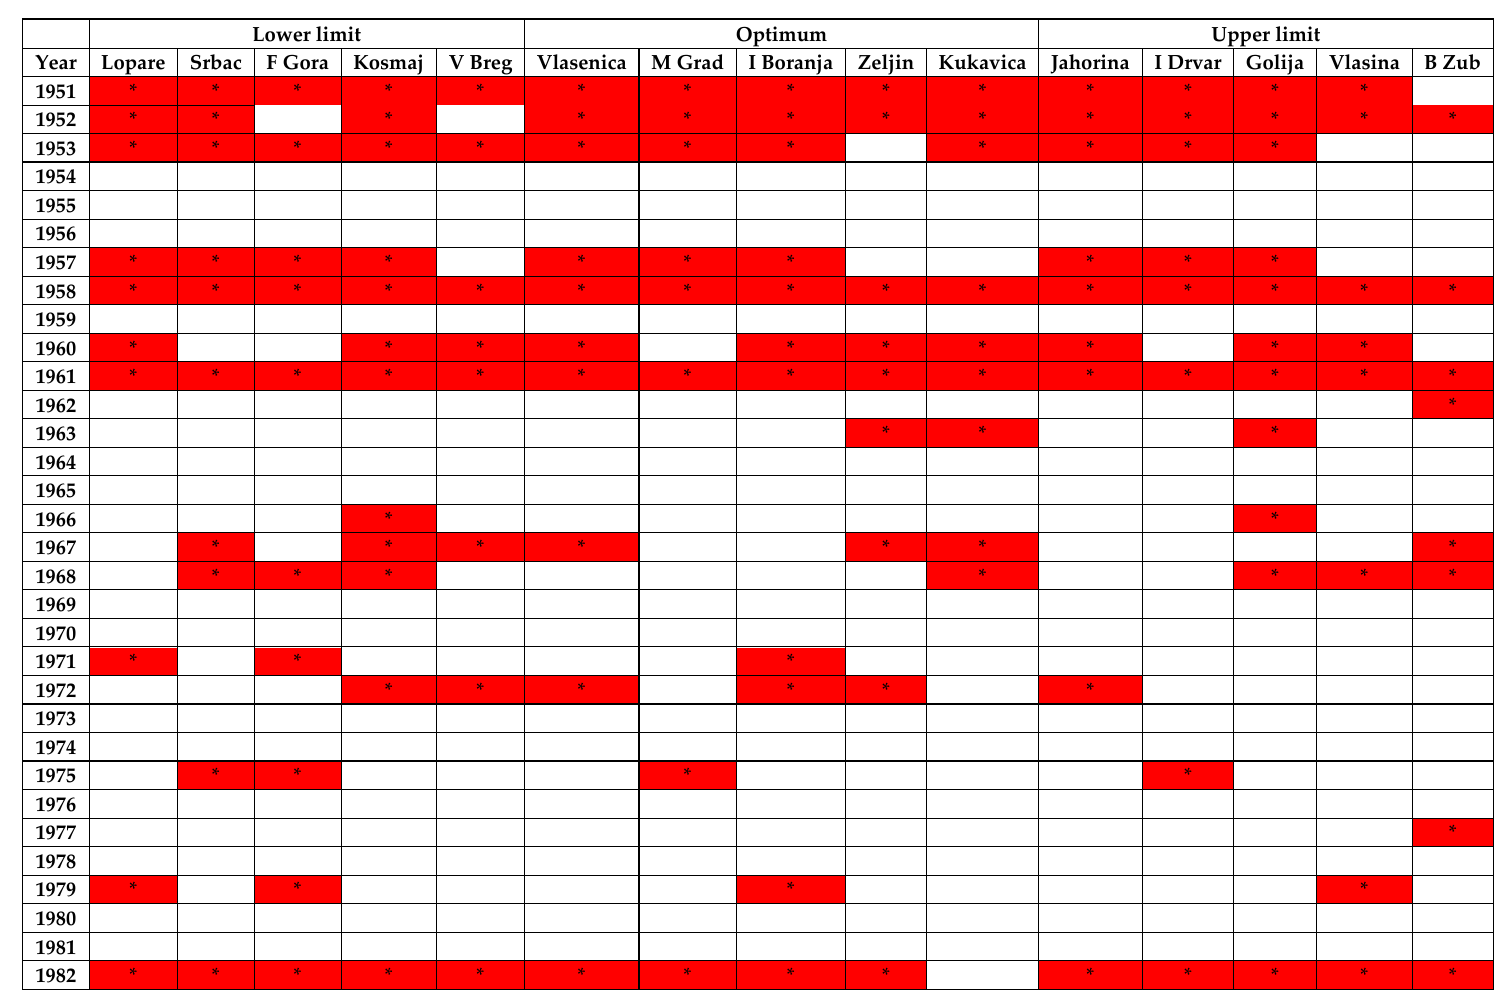
Table A2. Dry years at all analyzed sites.